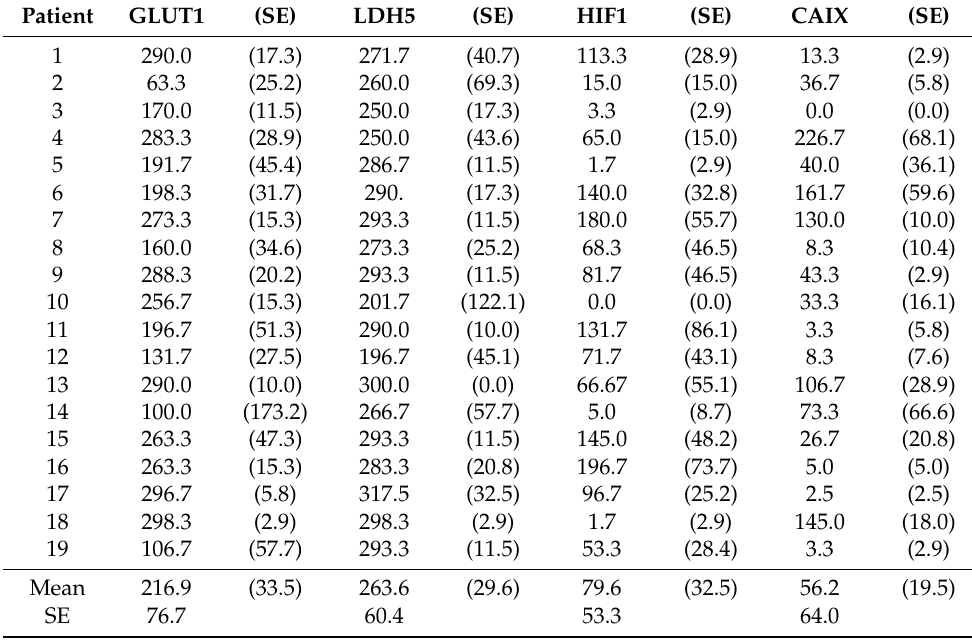
Figure 4. Differential analysis between FMISO and FAZA with ( 1 ) FMISO PET, ( 2 ) differential fixation, and ( 3 ) FAZA PET. With respect to CAIX immunohistochemistry, the mean score was 56.2 ( ± 64.0); for HIF1, the mean score was 79.6 ( ± 53.3). For LDH5, the mean score was 263.6 ( ± 60.4), and for GLUT1, 216.9 ( ± 767) (Table 2). We found no correlation between the different immunohistochemical analyses and with hypoxia PET. Each hypoxia tracer (FMISO and FAZA) for volumes and intensity was compared with immunohistochemical scores (HIF1- Alpha, GLUT-1, CAIX, and LDH5) (Table 3 and Figure 5). Table 2. Immunohistochemical